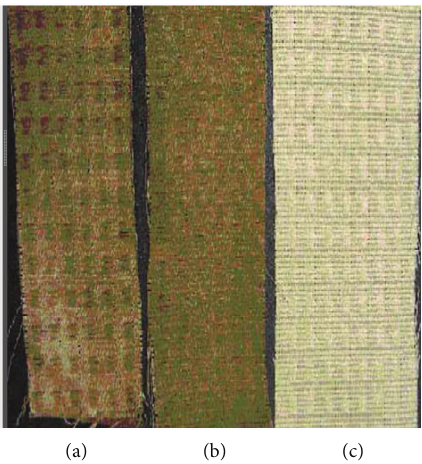
Figure 9: Antidust performance of polyester fabric. (a) Titanium dioxide coated fabric after flow of dust, (b) uncoated fabric after flow of dust, and (c) initial fabric before flow of dust